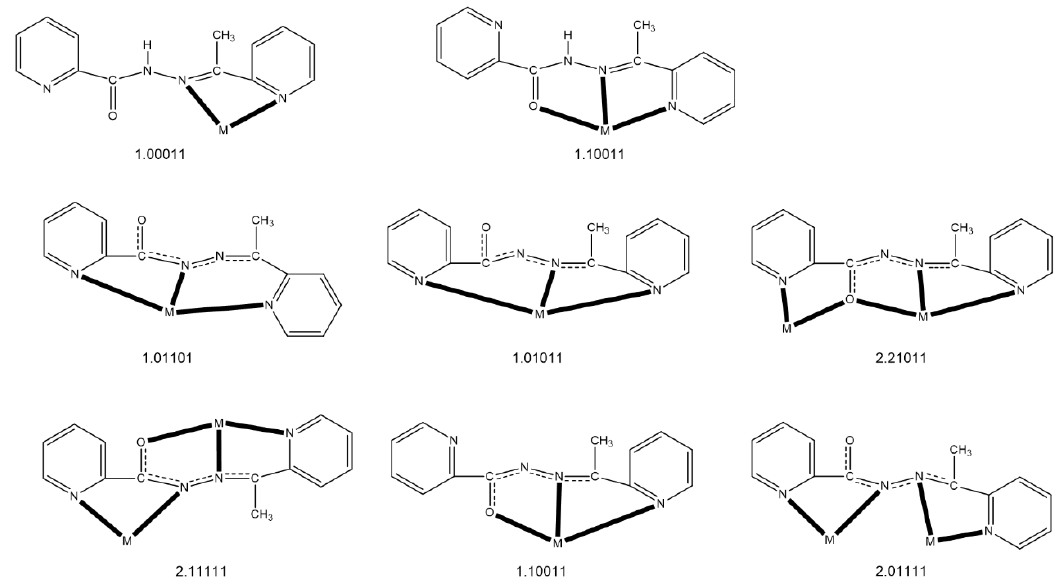
Figure 2. To date the crystallographically confirmed ligation modes of HL or L¯, and the Harris notation that describes these modes. The neutral ligand exists in the keto-amino form in the complexes. In the anionic ligand, the central OCNNC backbone has been drawn in a manner that emphasizes its delocalized nature which appears in most complexes. The coordination bonds are drawn with bold lines. M = metal ion. The structurally characterized complexes are listed in Table 3.